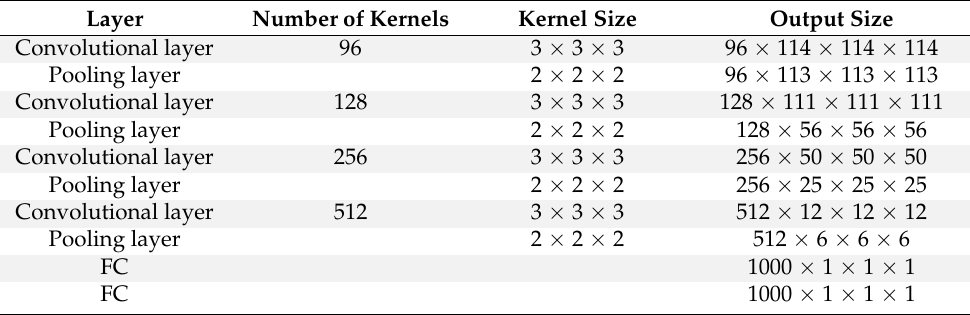
Figure 9. Corneal curvature slopes and angles computation. After classifying the image as keratoconus-affected, we use the feature extraction algorithm to identify the stage of keratoconus. The slopes are normalized according to the relative scale of the cornea-enclosed rectangle and give a perspective of the corneal curvature. The method performs classifi- cation of the 3D corneal images, according to the slope of the curvature in three dimen- sions. This enables the identification of keratoconus stages. There are three stages that characterize keratoconus. These stages are detected through geometrical metrics of the outer shape of the affected cornea, or by measuring its thickness. In our research, we used the geometry of the outer shape of the cornea by measuring the steepness of the greatest corneal curvature from the reconstructed 3D corneal images. The angle of curvature = 1800 − θ , where θ is calculated from the three displace- ments d1, d2, and d3, as in Equation (7). θ = cos (cid:2879)(cid:2869) (cid:3435)(d22 + d32 − d12)/(2 (cid:3400) d2 (cid:3400) d3)(cid:3439)